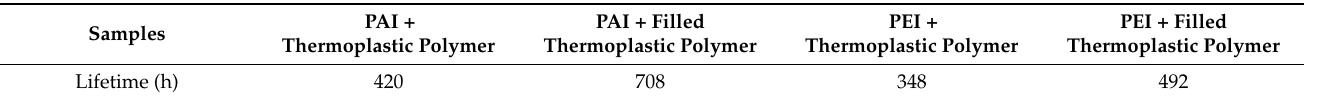
Table 2. Lifetime at 250 °C aging test.